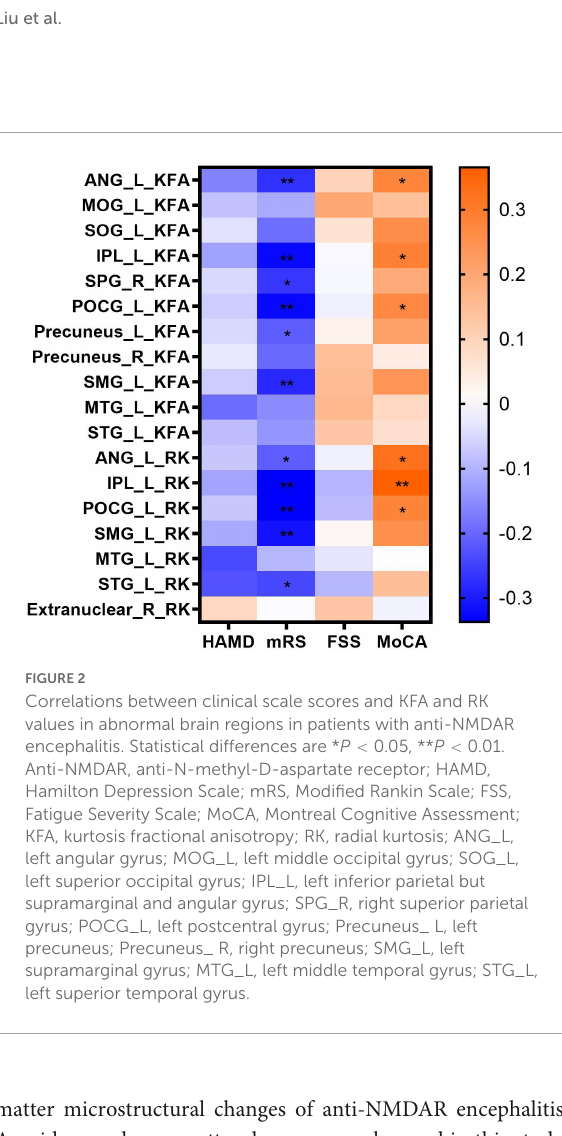
matter microstructural changes of anti-NMDAR